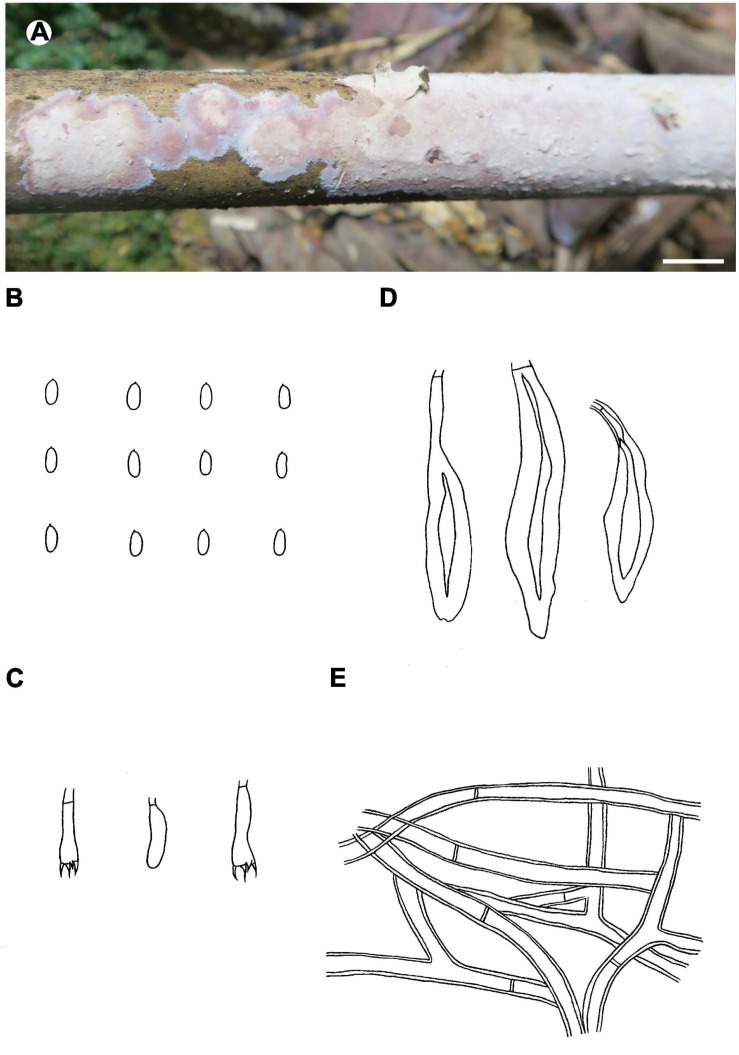
Phlebiopsis membranacea (A from He 3842, B–E from the holotype He 3849; scale bars: A = 1 cm, B–E = 10 μm). (A) Basidiomata; (B) basidiospores; (C) basidia and basidiole; (D) hymenial cystidia; (E) hyphae from subiculum.